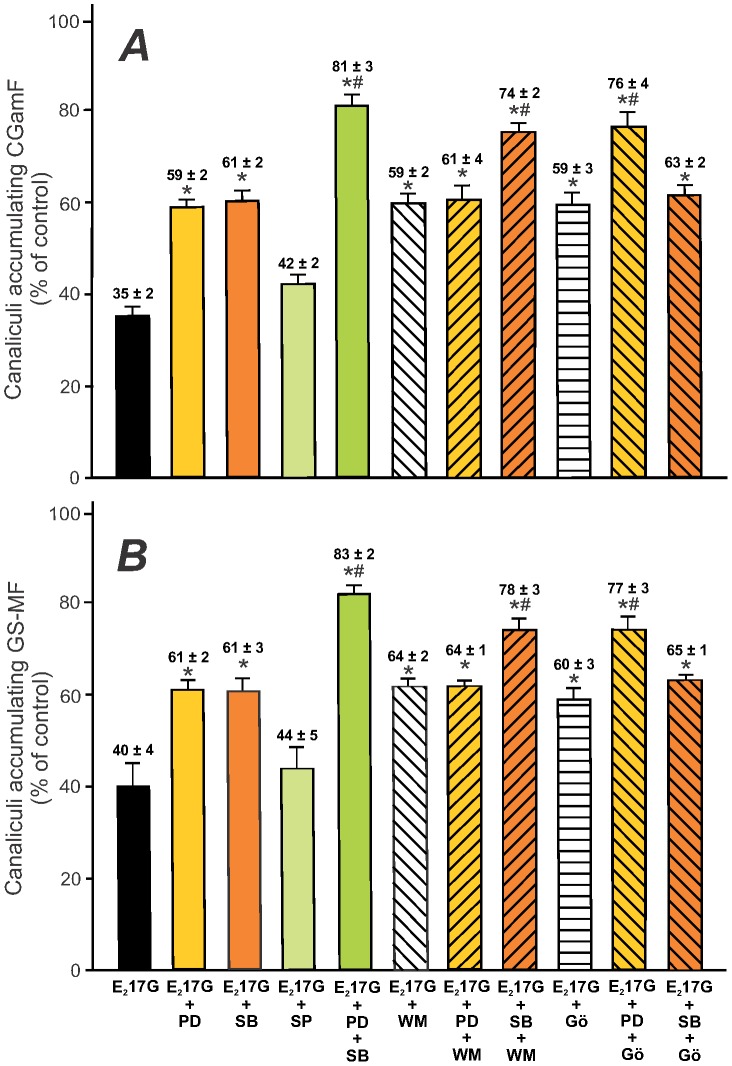
Effect of the inhibition of p38, ERK1/2 and JNK1/2, or the coinhibition of cPKC-ERK1/2, PI3K-p38, or p38-ERK1/2, on E217G-induced impairment of the canalicular accumulation of the Bsep and Mrp2 fluorescent substrates in IRHCs.IRHCs were incubated with E217G (200 µM, 20 min) (or DMSO in controls), with or without pretreatment for 15 min with the JNK1/2 inhibitor SP600125 (1 µM), the ERK1/2 inhibitor PD98059 (PD; 5 µM), and/or the p38 inhibitor SB203580 (SB; 1 µM), together or not with the cPKC inhibitor Gö6976 (Gö; 1 µM) or PI3K inhibitor wortmanin (WM; 100 nM). Canalicular accumulation CGamF (Bsep substrate, panel A) and GS-MF (Mrp2 substrate, panel B) was determined as the percentage of couplets displaying visible fluorescence in their canalicular vacuoles from a total of at least 200 couplets per preparation. The results are expressed as percentages of the control group and are shown as mean ± SEM (n = 3–4). *P<0.05 vs. E217G, and #P<0.05 vs. E217G-WM, E217G-Gö, E217G-PD or E217G-SB.